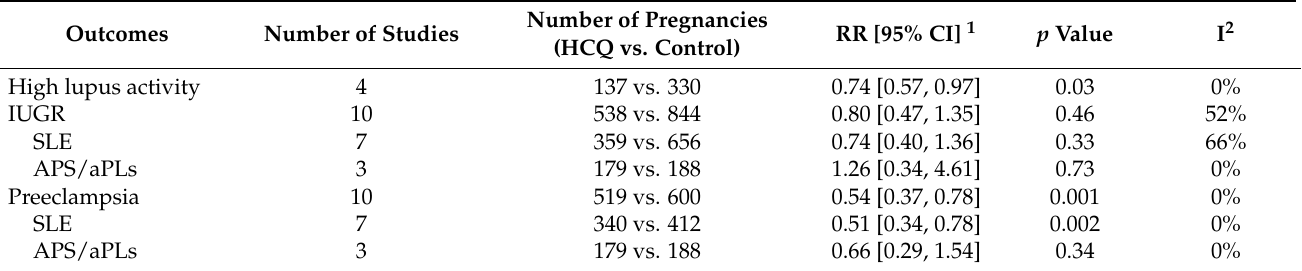
Table 1. Relative risk of each outcome.